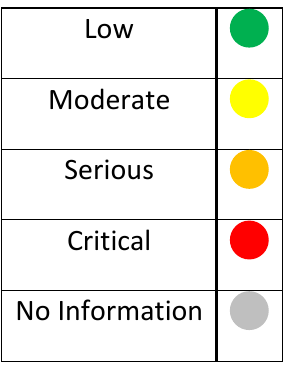
Supplemental table S2. Risk of bias assessed using the ROBINS-I